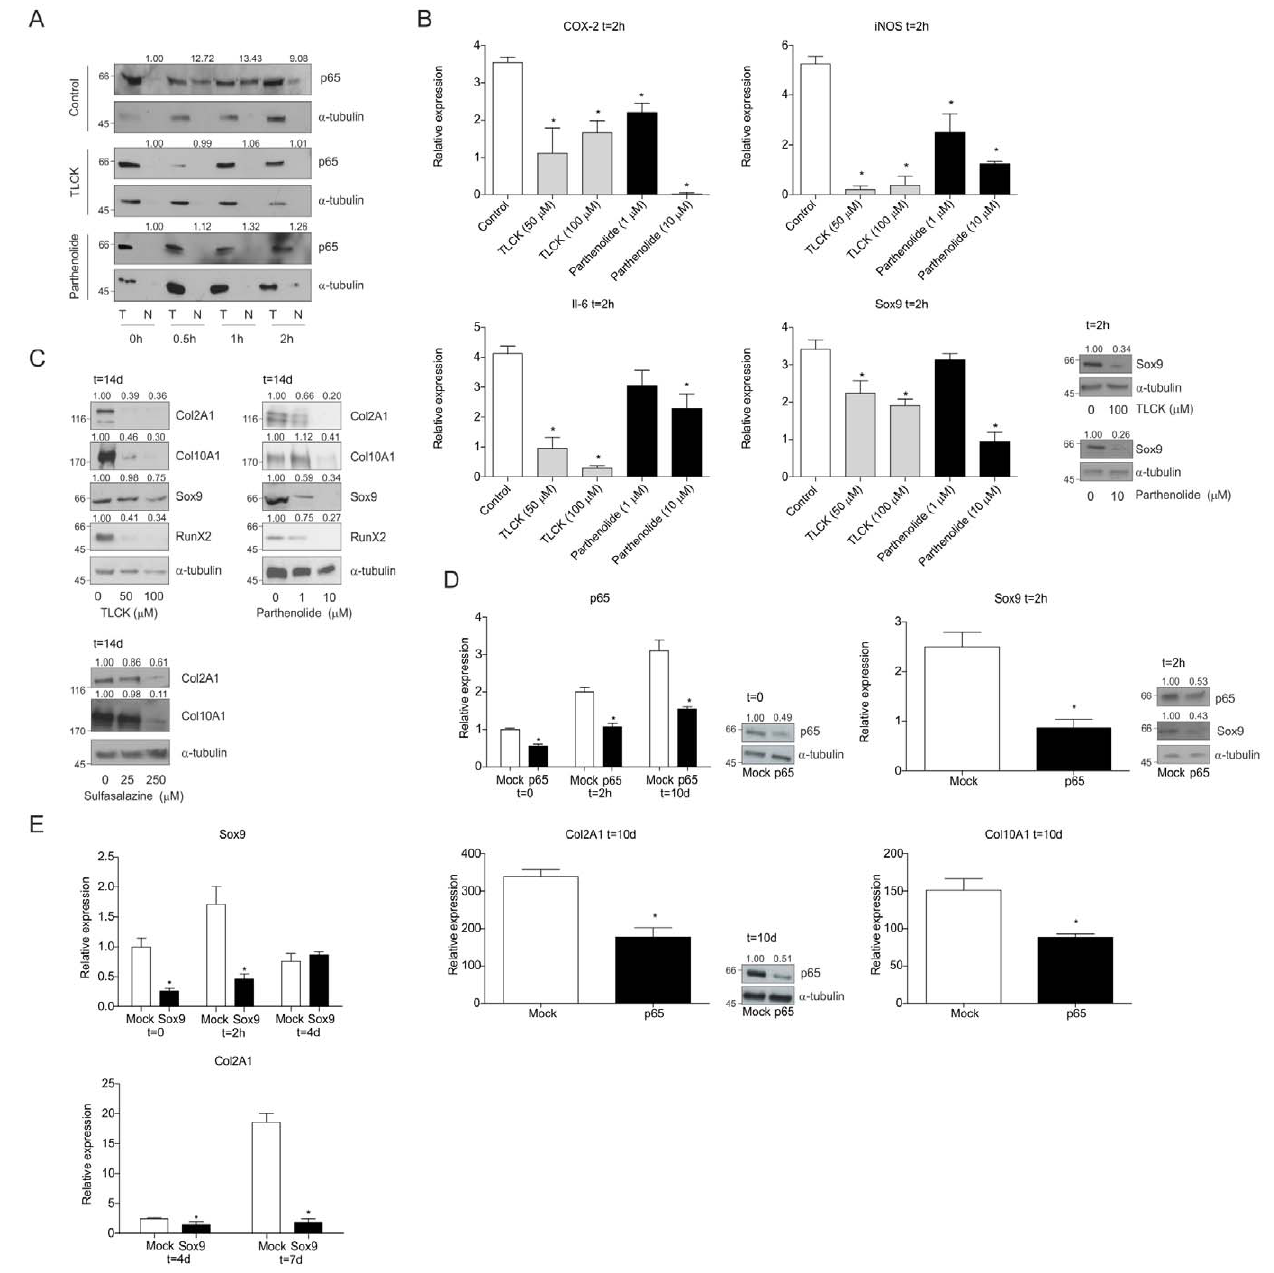
Figure 2. Inhibition of early NF- k B/p65-activation leads to impaired ATDC5 differentiation. A: Cells were differentiated in the absence (control) or presence of TLCK (100 m M) or Parthenolide (10 m M) and total (T) and nuclear (N) fractions were prepared. NF- k B was detected as p65. B: Expression of COX-2, iNOS, Il-6 and Sox9 mRNAs at 2 hours in differentiation in the presence of TLCK or Parthenolide. Sox9 protein expression was determined from similar samples (right panel set). C: Protein expression at day 14 in differentiation of Col2A1, Col10A1, Sox9 and RunX2 with TLCK (left panels), Parthenolide (right panels) or Sulfasalazine (lower left panels). D: Knock-down (KD) of p65 mRNA and protein at 0, 2 hours and 10 days in differentiation (‘‘Mock’’ below figures indicates scrambled siRNA and ‘‘p65’’ below figures indicates p65 KD). Upper right set: expression of Sox9 mRNA and protein in p65 KD cells at 2 hours in differentiation. Lower sets: messenger RNA expression of Col2A1 and Col10A1 at 10 days in differentiation of p65 KD cells. *=p , 0.05. E: Sox9 mRNA expression at 0, 2 hours and 4 days in differentiation of cells transfected one day prior to differentiation with scrambled (indicated by ‘‘Mock’’) or Sox9 siRNA (indicated by ‘‘Sox9’’) (upper panel). Col2A1 mRNA expression was determined at day 4 and 7 in differentiation (lower panel). *=p ,